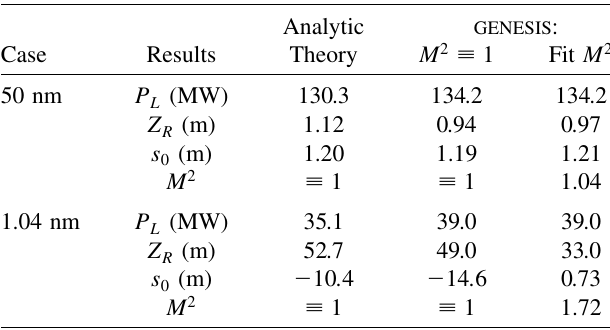
TABLE I. Comparison between analytic model and simula- tions using GENESIS for two case